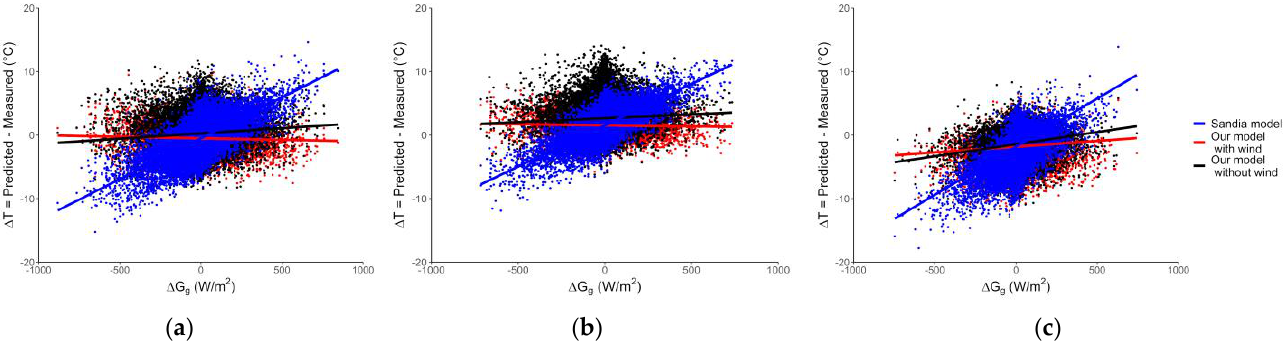
Figure 2. A comparison of the difference between predicted and measured temperature of PV module in three different locations, resulting in changing of incident POA with 5-min time steps: ( a ) Tri An; ( b ) Da Nang; and ( c ) Ha Noi.